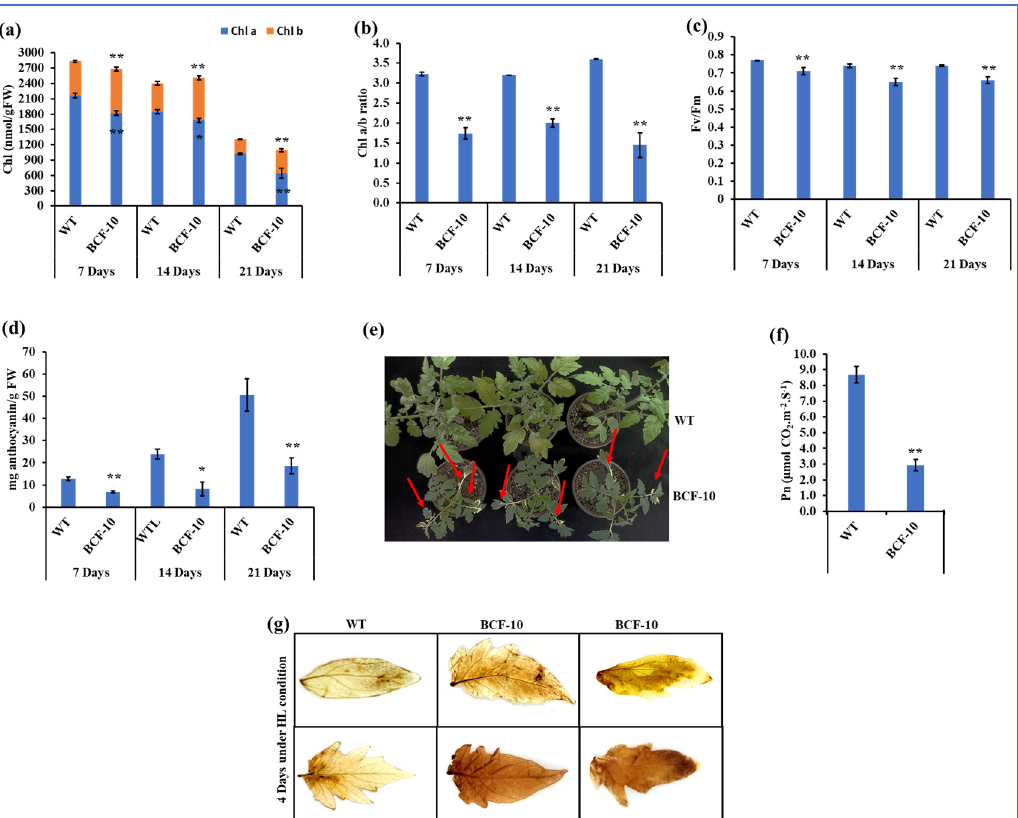
Figure 6. Chl metabolic characters, photosynthetic rate, and H 2 O 2 accumulation of WT and BCF − OE plants under HL growth conditions. ( a ) Chl a and Chl b content of WT and BCF − OE plants. ( b ) Chl a/b ratio. ( c ) Fv/Fm values of 7, 14, and 21 days of HL. ( d ) Anthocyanin accumulation. ( e ) BCF − OE plants photodamaged under HL growth conditions. The red arrow shows the plant’s photodamaged. ( f ) Net photosynthetic rate (Pn) was measured after 14 days at HL growth conditions. ( g ) H 2 O 2 accumulation of HL − grown WT and BCF − OE plants detached leaves were exposed to HL for 2 and 4 days and stained with 3,3 − diaminobenzidine (DAB). The data point is the average of five replicates, and SE represents error bars. Asterisks indicate a significant difference compared to WT (Student’s t − test, * p < 0.05, ** p < 0.01).